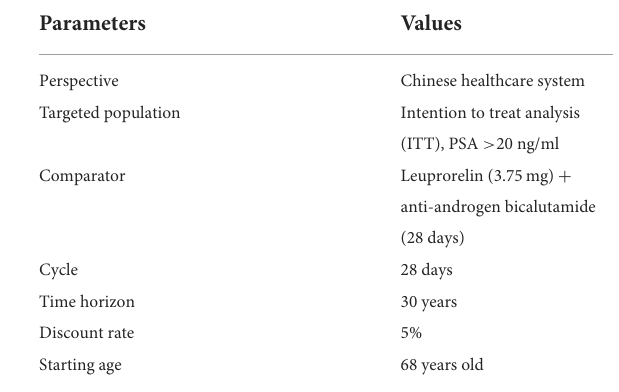
TABLE 1 The basic settings of the